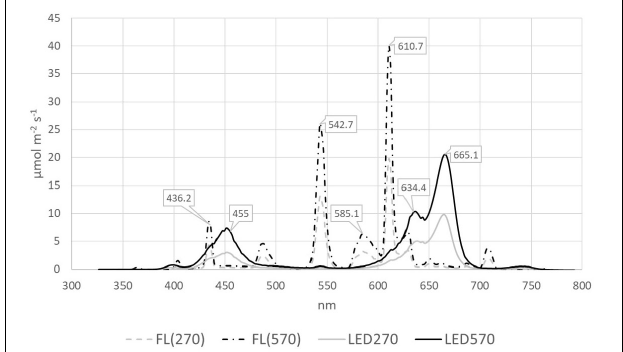
FIGURE 1 | Spectral distribution including peak wavelengths of the four light treatments, FL(270) in dashed gray, FL(570) in dashed black, LED(270) in gray and LED(570) in black. Fluorescent (FL) light provided by T5 fluorescent lamps. LEDs radiation provided by PAR customized LED array (diodes emitting in the blue: 410, 430, and 460 nm and, diodes emitting in the red: 610, 630, and 660